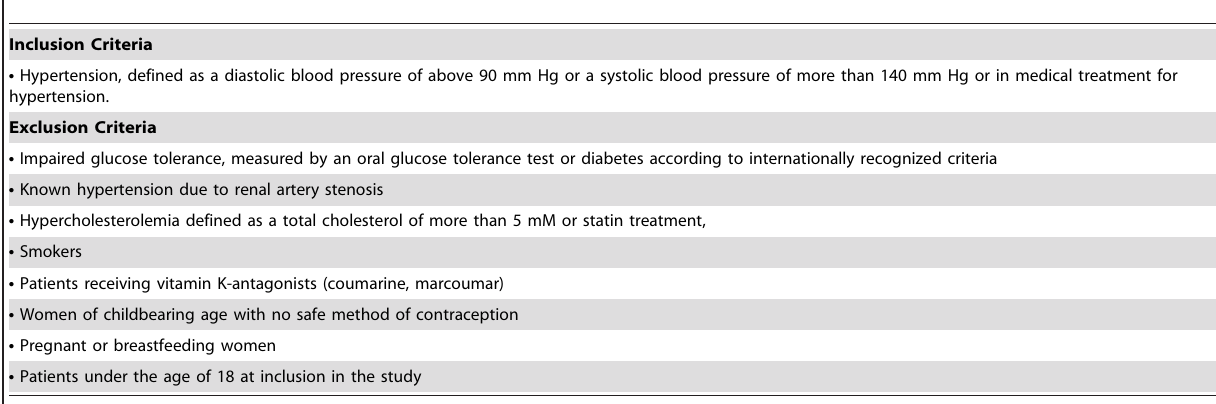
Table 1. In and exclusion criteria for the